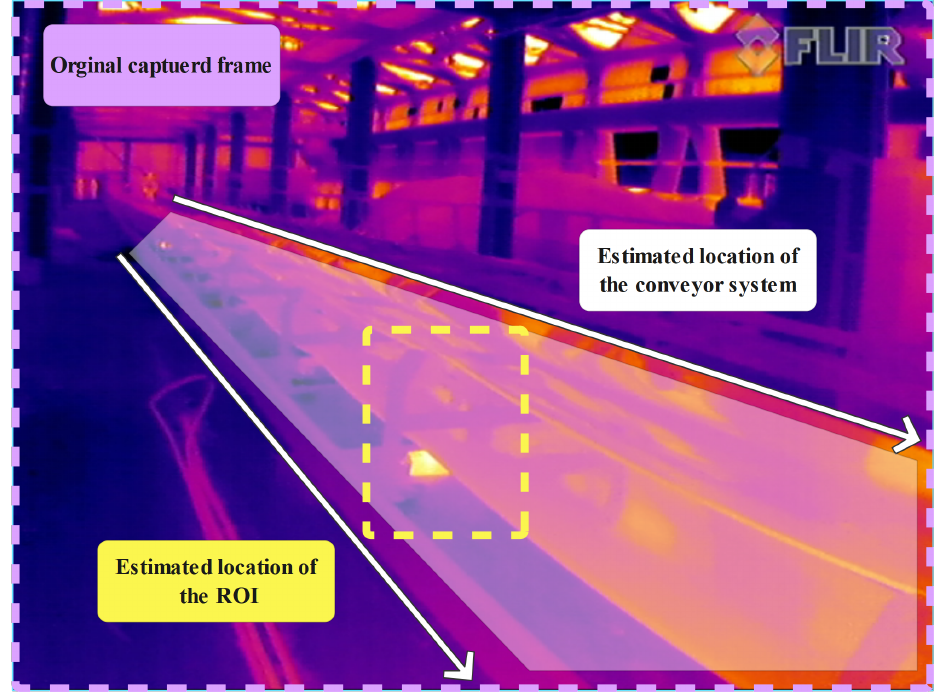
Figure 2. The location of a predefined ROI on an original